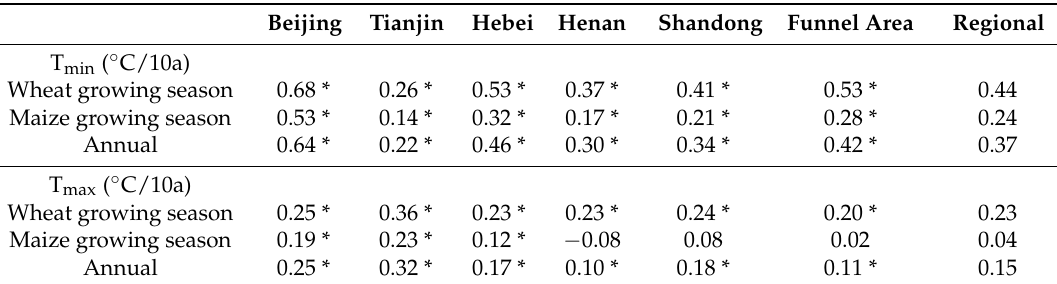
Table 2. The province-wide, funnel area, and regional statistics for the wheat, maize, and annual temperature trends.